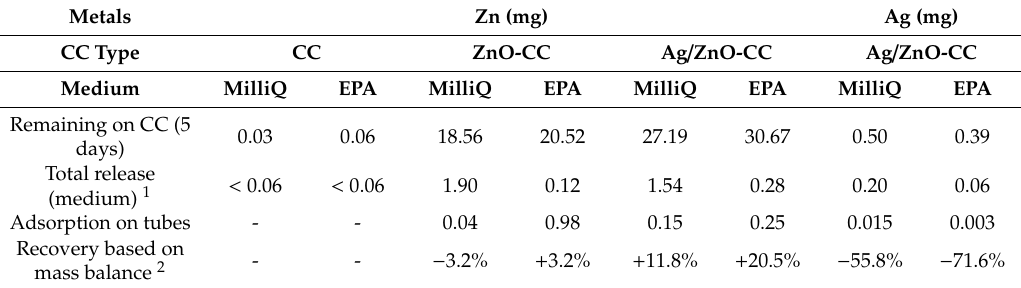
Figure 3. Characterization of the sterilization carbon cloth containing Ag / ZnO nanomaterials by transmission electron microscopy (TEM) and scanning electron microscope (SEM): ( a – c ) nanostructure of Ag / ZnO on surface of carbon cloth, ( a , b ) were acquired by SEM and ( c ) was acquired by TEM. ( d – f ) Nanostructure of ZnO growth on the surface of carbon cloth, ( d , e ) were acquired by SEM and ( f ) was acquired by TEM. ( g , h ) Structure of the carbon cloth, which was acquired by SEM. Table 1. The mass balance of metals on the carbon cloth in the beginning and after five